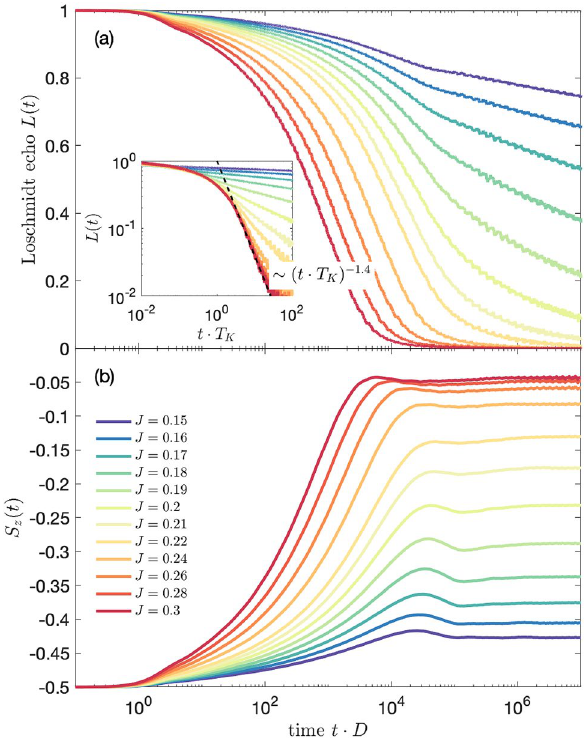
Figure 4. ( a ) The Loschmidt echo L ( t ) and ( b ) the evolution of the expectation value of the impurity’s spin S z ( t ) for the quench in J 1 ≡ J starting from 0 to value in given in the legend, with J 2 = 0 and assuming a finite magnetic field B z = 4 · 10 − 5 applied to the system. The inset in ( a ) presents L ( t ) plotted as a function of t · T K . The other parameters are the same as in Fig.